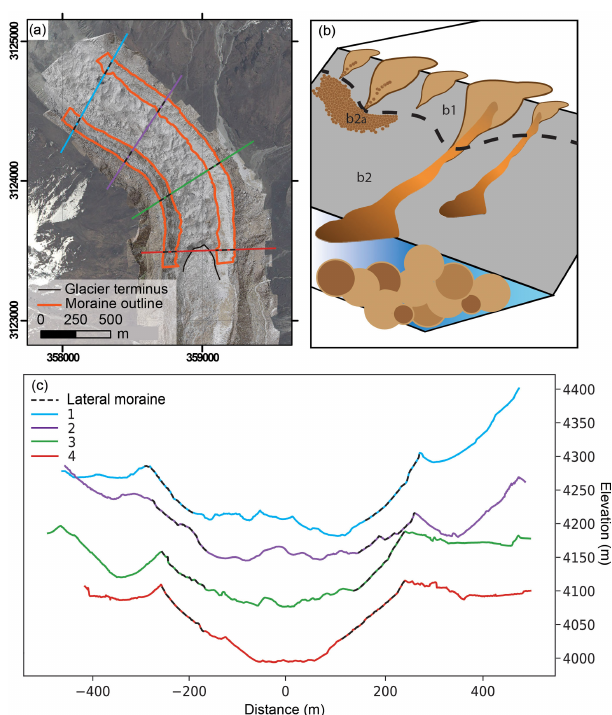
Figure 3. Cross sections over the glacier and moraine, with their locations (a) and corresponding elevation profile (c) . They clearly indicate that the distal slope of the moraine has an opposite aspect to the proximal slope, due to which there is no debris input from higher slopes and rockwalls in the valley. In panel (b) , the different sections of the moraine are indicated, with the upper gullied part (b1) , the debris apron or coalescing debris cones (b2) and the smooth section of the debris apron interpreted as gully washout deposition (b2a) .